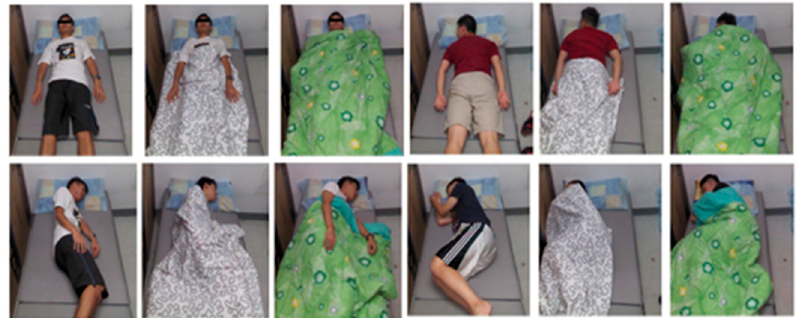
Figure 5. Examples of images from the iSP pilot dataset [43].